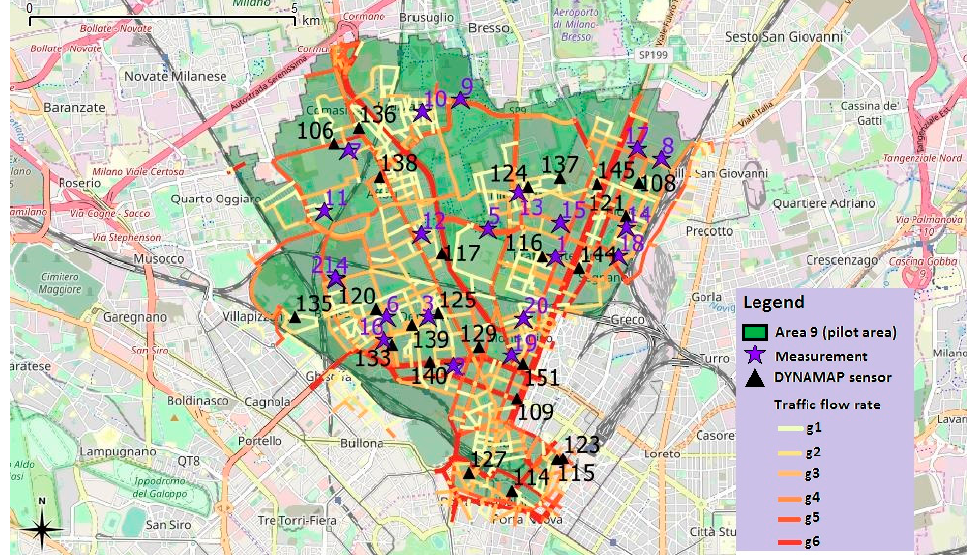
Figure 9. District 9 of the city of Milan city. Streets color corresponds to the different groups of streets according to range of non-acoustic parameter x : (0.0–3.0) ( g 1 ), (3.0–3.5) ( g 2 ), (3.5–3.9) ( g 3 ), (3.9–4.2) ( g 4 ), (4.2–4.5) ( g 5 ), (4.5–5.20) ( g 6 ). Black triangles and purple stars represent the sites where the monitoring stations are installed and the position of test measurements,